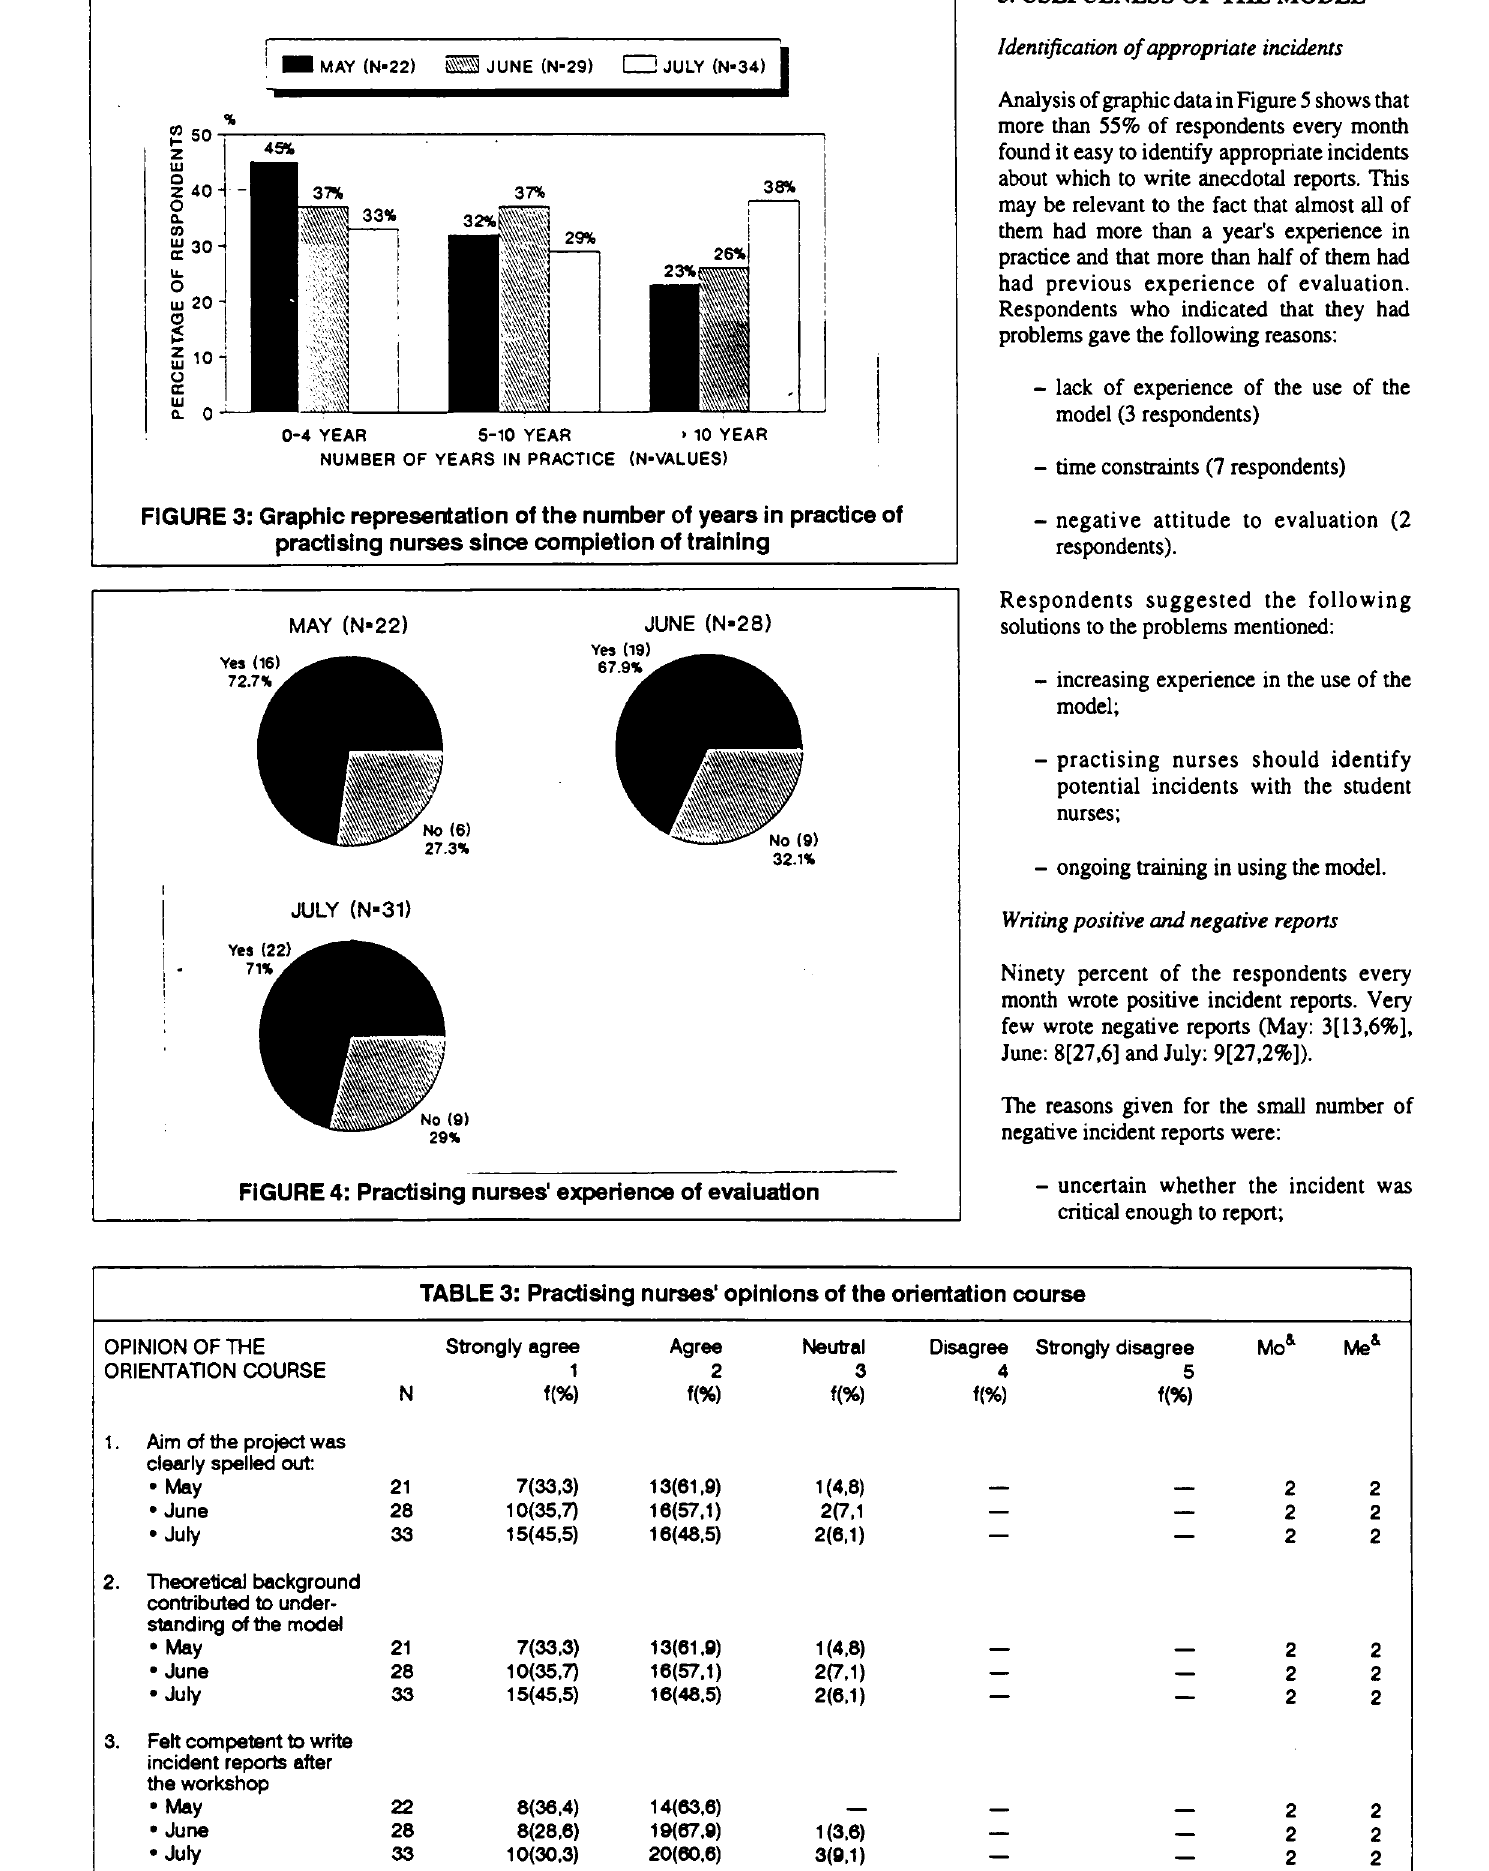
FIGURE 3: Graphic representation of the number of years in practice of